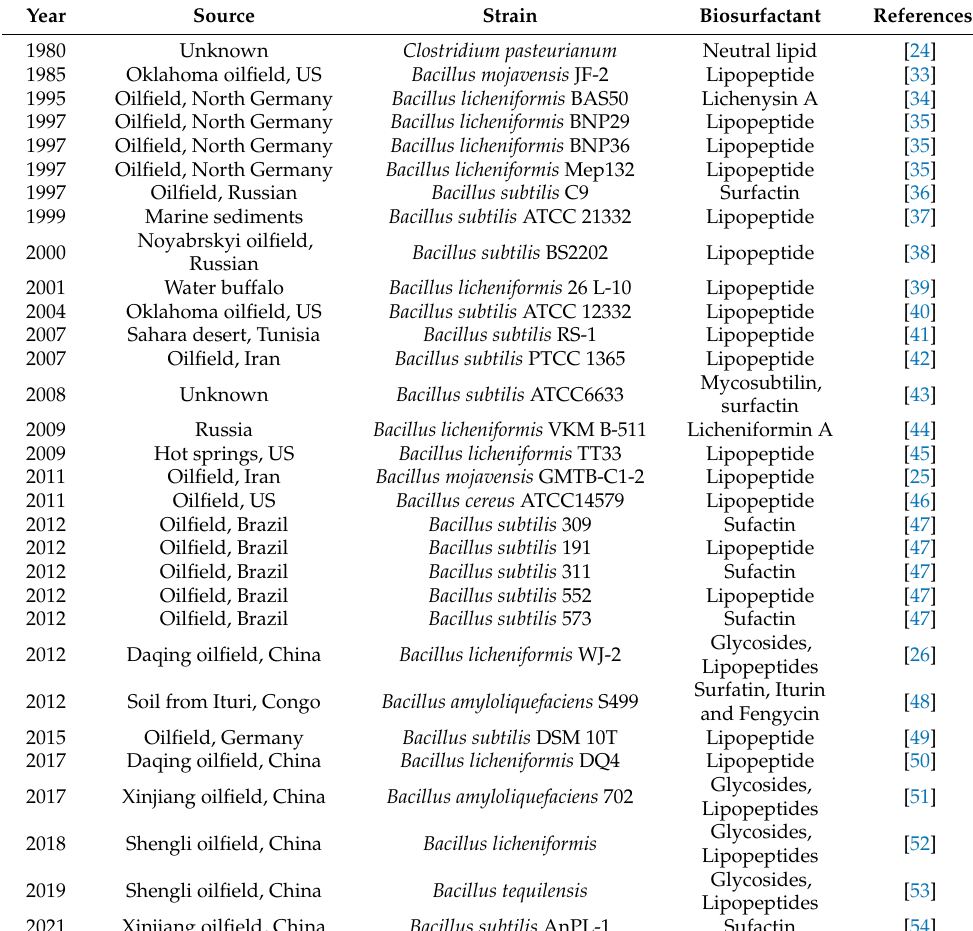
Table 1. Information of lipopeptide-producing strains ( Bacillus ) under anaerobic